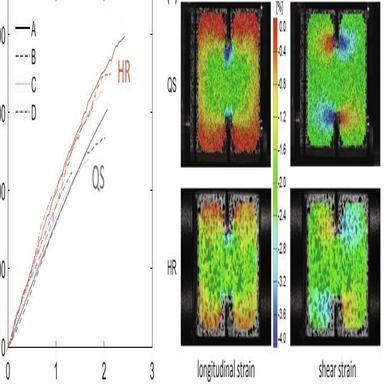
Bar strain wave group of a SHPB DENC test, and dynamic stress equilibrium check for specimens of sizes A (a and b) and D (c and d).